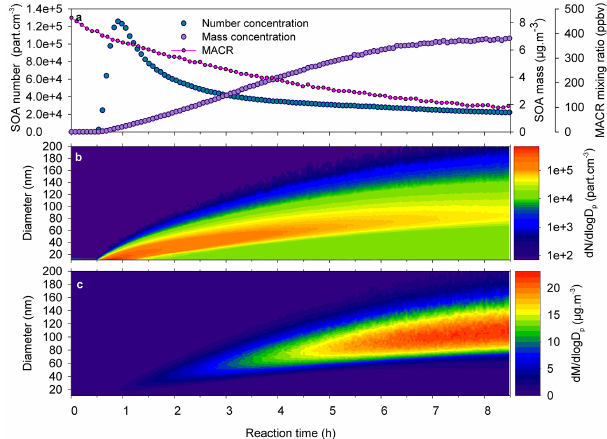
Figure 6. Time profiles of measured (a) SOA mass and number concentrations, (b) number size distribution and (c) mass size dis- tribution during MACR photooxidation (experiment M240512) per- formed without seed particles and with NO x as OH source. A parti- cle density of 1.4gcm − 3 was assumed (see